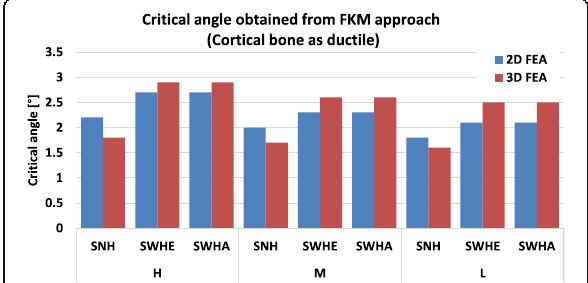
Fig. 15 Critical angle obtained using FKM approach (Cortical bone as ductile): The critical angle was the angle obtained when the equivalent stress in the specimen reached the assessed static strength. The higher critical angles were obtained for specimens with drilled holes (SWHE and